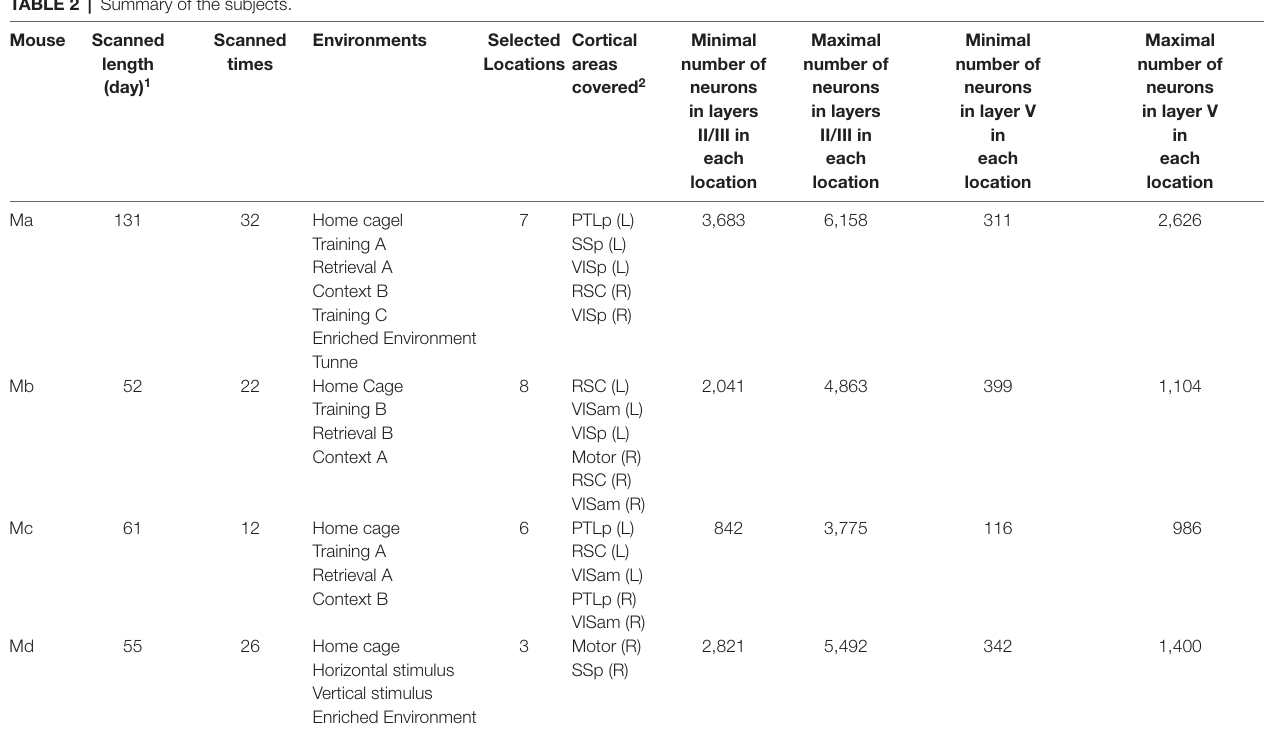
TABLE 2 | Summary of the subjects. Mouse Scanned length